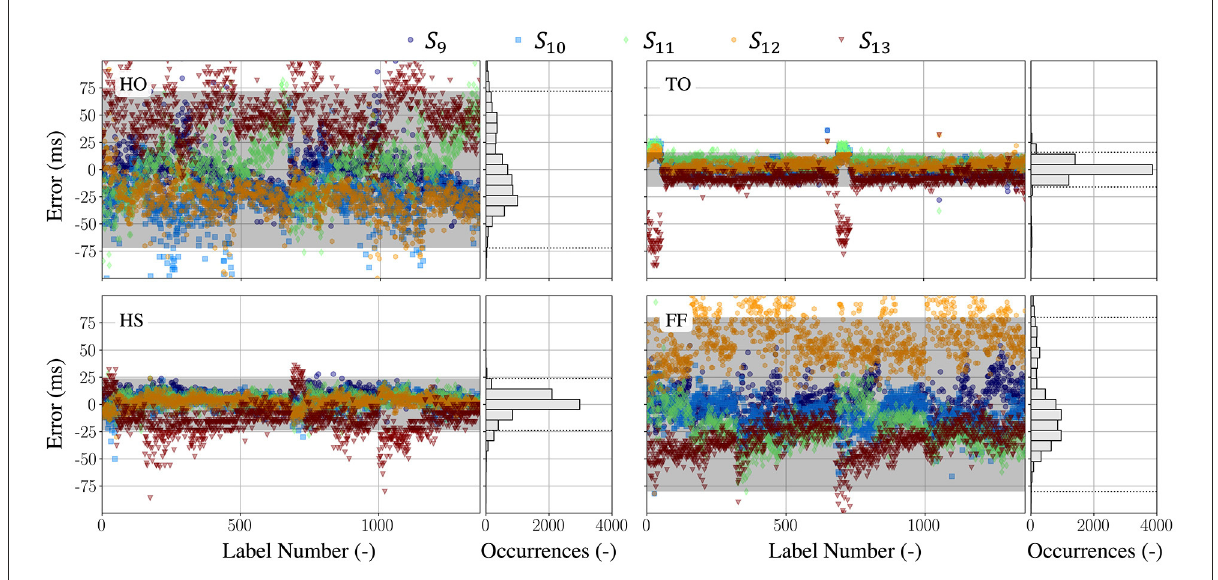
FIGURE5 The error distributions and the LOA of the labels for four gait events HO, TO, HS, and FF. The LOA in this work for HO, TO, HS, and FF are 72ms, 16ms, 24ms, and 80ms respectively. In each subplot: the left plot shows all identified manual labels from five labelers S 9 − S 13 as deviation from the average label—the gray area is the LOA band; the right plot shows the distribution of all label errors—it can be understood as a projection of all samples of the left plot onto the y − axis. The dotted lines in the histogram mark the LOA band.